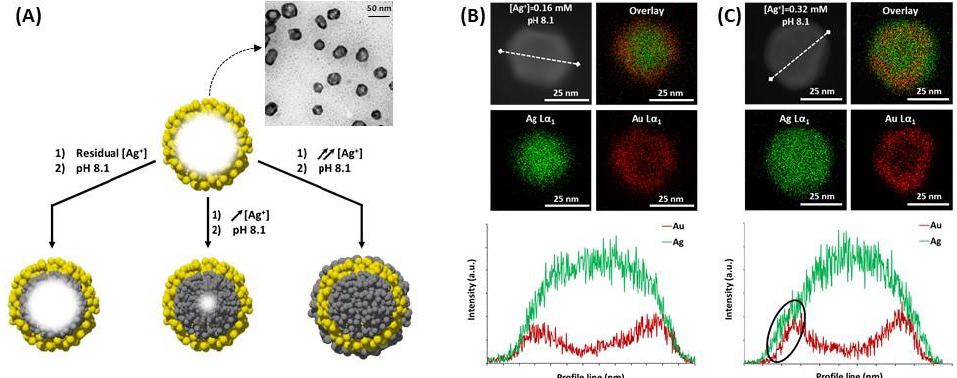
Figure 18. ( A ) Illustration of the reduction and growth process of Ag on the inner and outer surfaces of porous gold nanoshell (AuNS) with increasing amounts of Ag + in the surrounding medium. STEM elemental mapping (Ag, Au, and overlay) of AuNS obtained after adding Ag + : ( B ) [Ag + ] = 0.16 mM and the corresponding elemental profile along the white hatched line and ( C ) [Ag + ] = 0.32 mM and the corresponding elemental profile along the white hatched line. The black ellipse in ( C ) highlights the reduction and growth of Ag at the external surface once the inner volume is completely filled. Adapted from [163]. Copyright (2019), American Chemical Society.